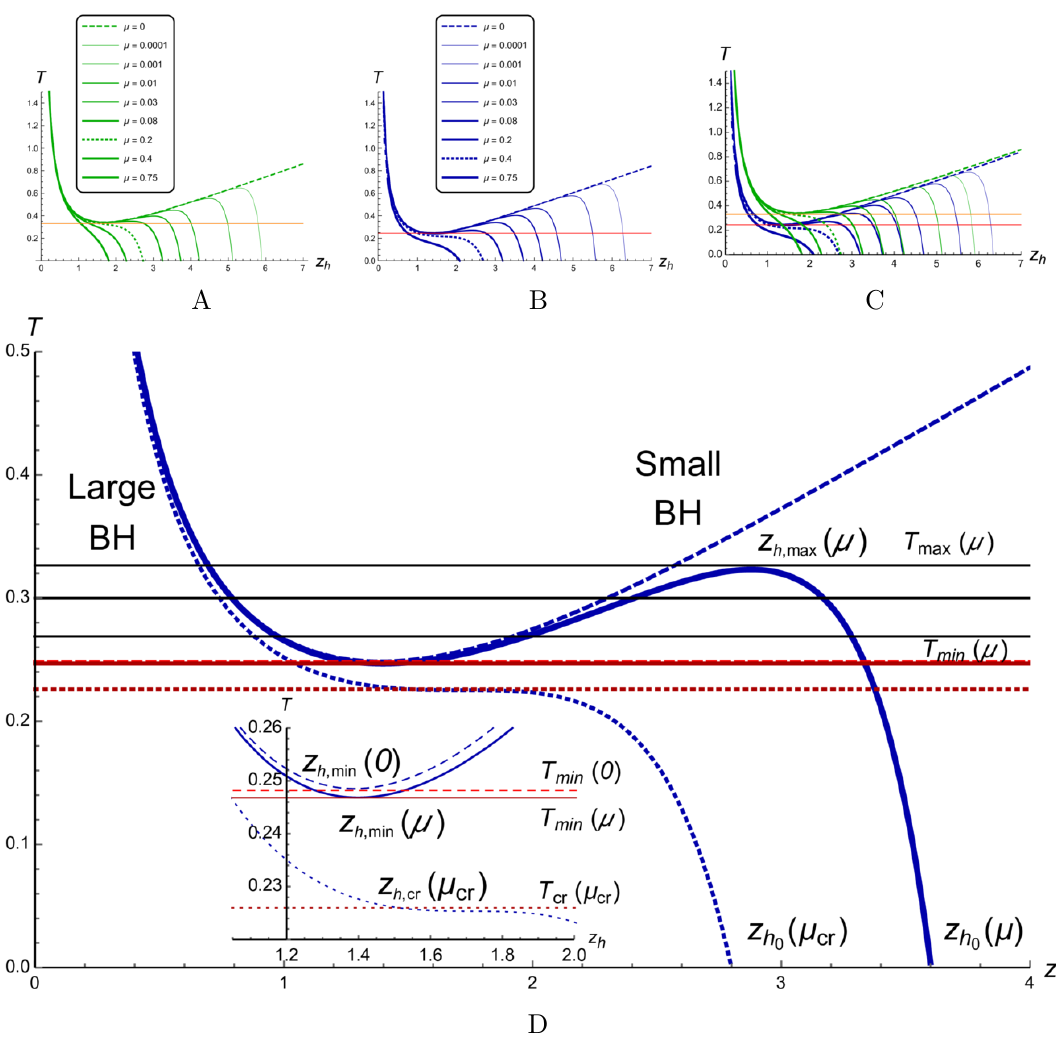
Figure 18 . The dependence of temperature T ( z h ; (cid:22); c; (cid:23) ) on z h for c = (cid:0) 1 and di(cid:11)erent (cid:22) for isotropic (A) and anisotropic, (cid:23) = 4 : 5, (B) cases, their comparison with the same line labels (C); anisotropic case for c = (cid:0) 1 and di(cid:11)erent (cid:22) in details (D); the horizontal orange and red lines show locations of the global minima in isotropic and anisotropic cases,